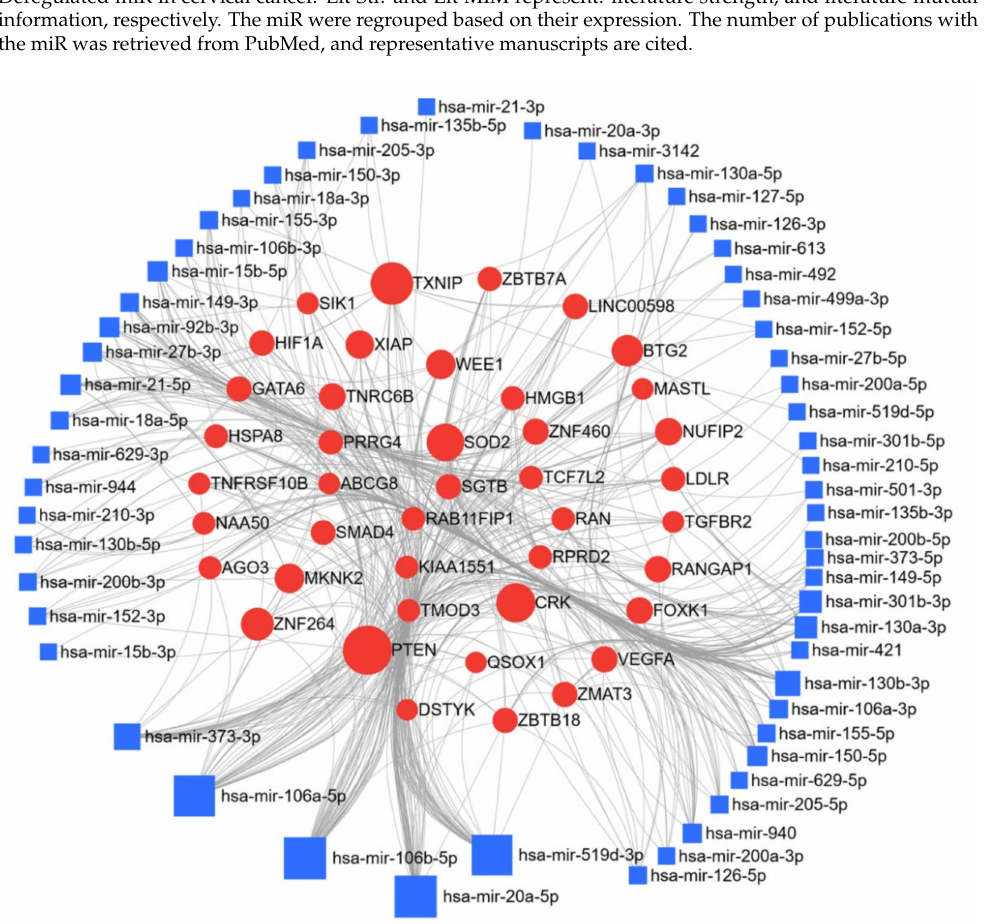
Figure 8. Network of upregulated miR in cervical cancer: miRs deregulated in cervical cancer were searched in the PubMed database using IRIDESCENT. The network of upregulated miRs generated using miRNET (degree filter cutoff 10) is shown. The blue squares represent miR, and the red dots represent target genes of these